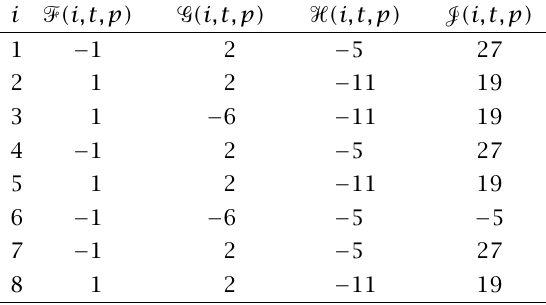
(cid:10) φ( − 1 ),φ(t),φ( 1 − t)